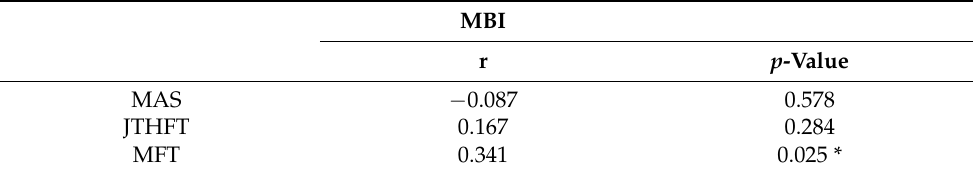
Table 4. Correlation of spasticity, hand function, or upper limb function with activities of daily